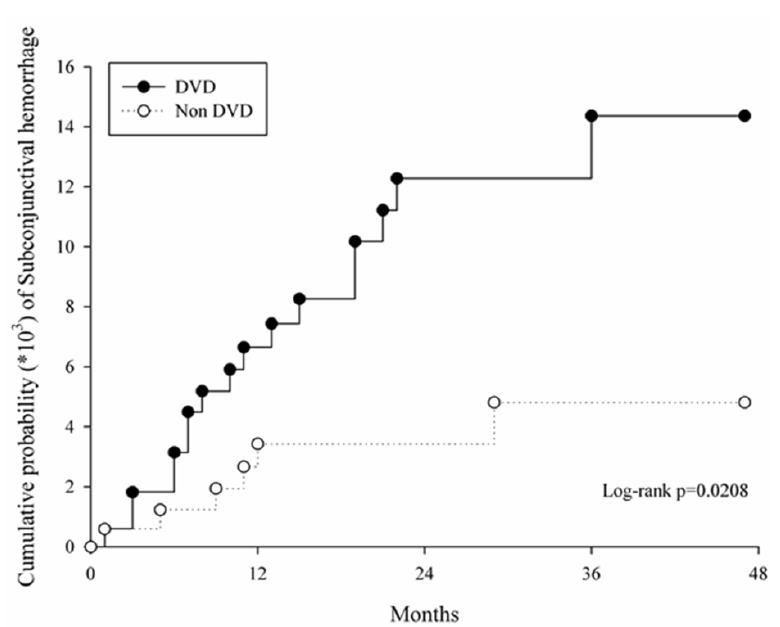
Figure 2. Curves with cumulative proportion of subconjunctival hemorrhage in the propensity score matched study and control groups. Table 3. Sensitivity analysis of the risk of subconjunctival hemorrhage in the study group. Subgroups